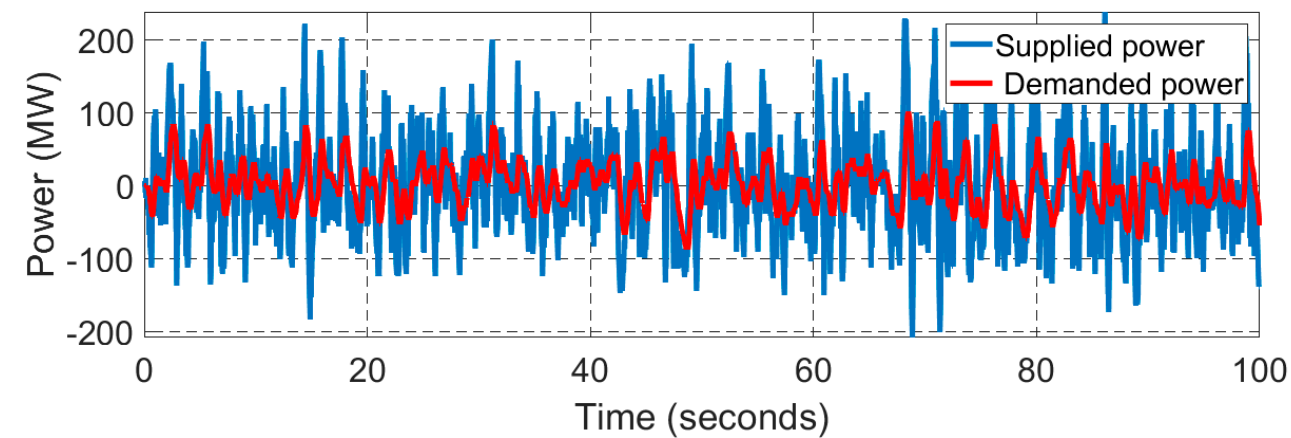
Figure 21. The active power mismatches between the supplied power and demanded power in Area 2 under fault condition.